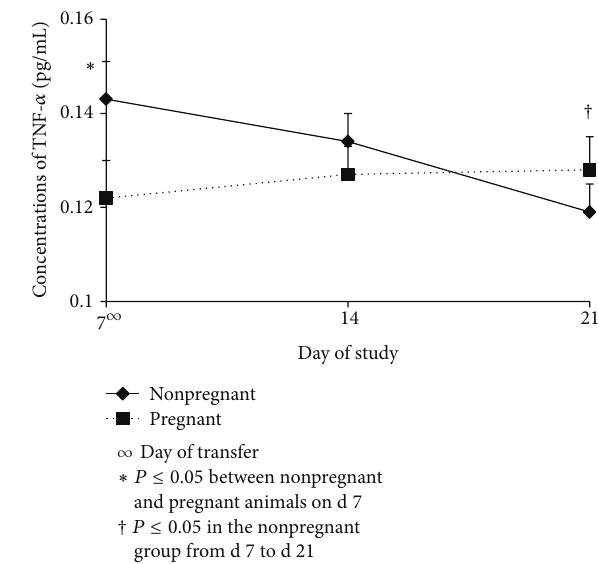
Figure 3: Concentrations (Mean ± SEM) of TNF- 𝛼 among treat- ment groups on d 7, d 14, and d 21. Treatment 𝑥 day inter- action (𝑃 ≤ 0.05) ; CIDR = controlled internal drug release; GnRH = gonadotropin releasing hormone; hCG = human chorionic gonadotropin.